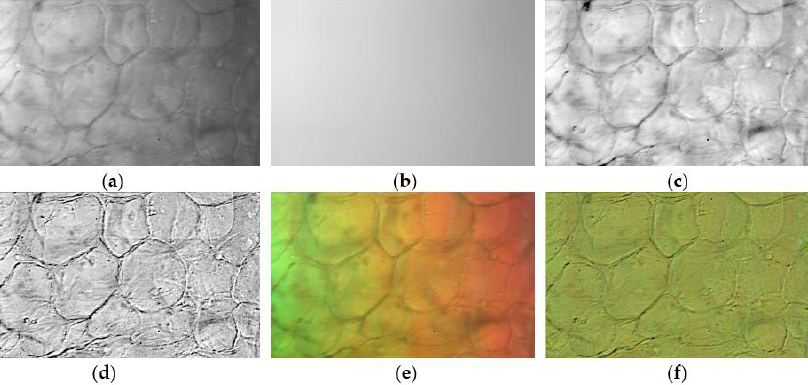
Figure 3. Non-uniformity correction of blueberry hyperspectral microscope images acquired by FPI-HMI at 530 nm: ( a ) raw image, ( b ) image from mean filter with filter size 300 × 300, ( c ) non-uniformity-corrected image, ( d ) deconvoluted and 1% linear stretched image, ( e ) raw three-band image, ( f ) deconvoluted three-band image after the correction.